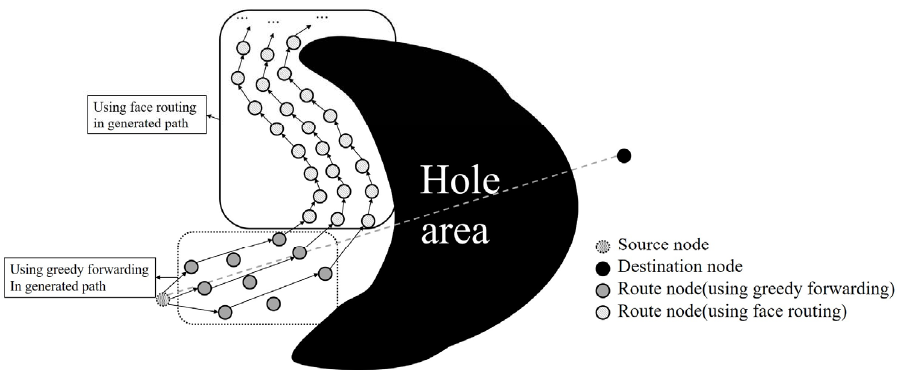
Figure 1. The frequent communication problem when face routing is used near the hole